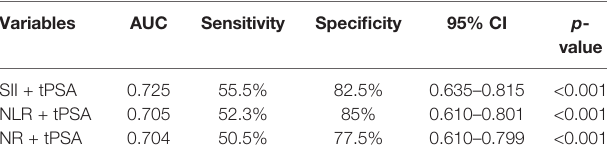
TABLE 4 | AUC, sensitivity, and speci fi city values of SII, NLR, and NR combined with tPSA.